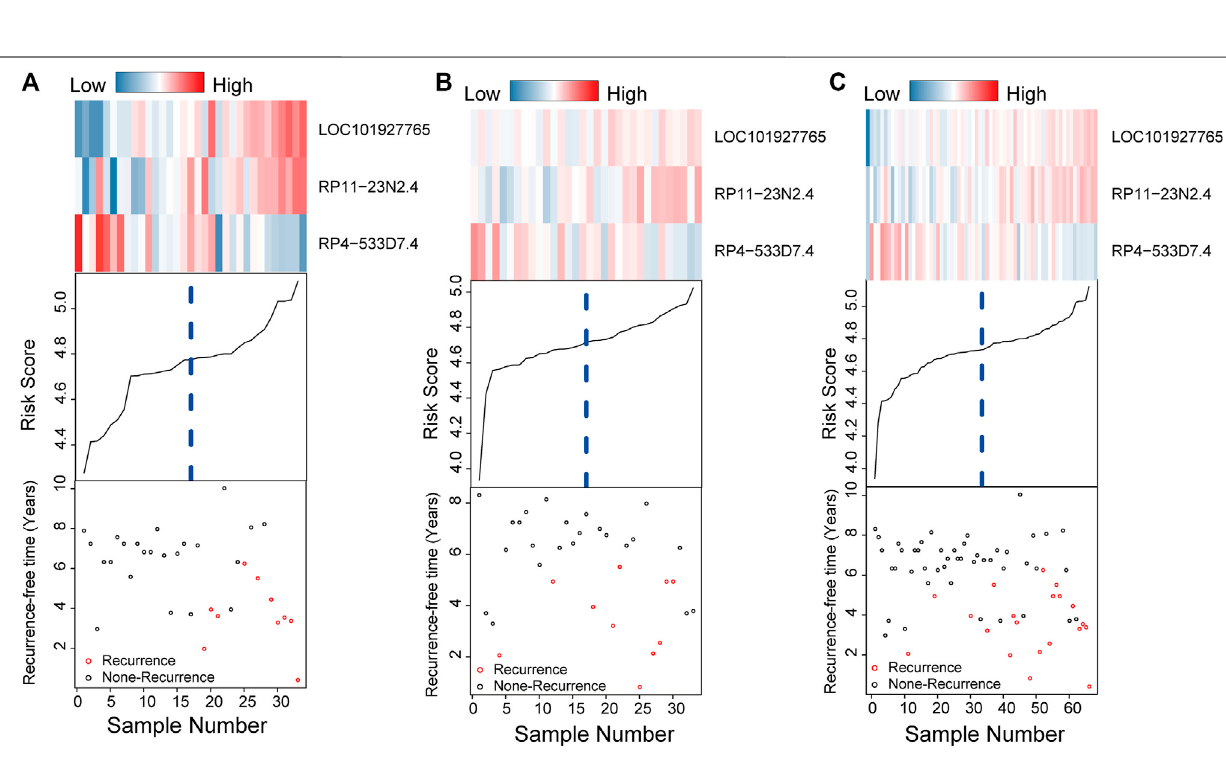
Frontiers in Genetics |